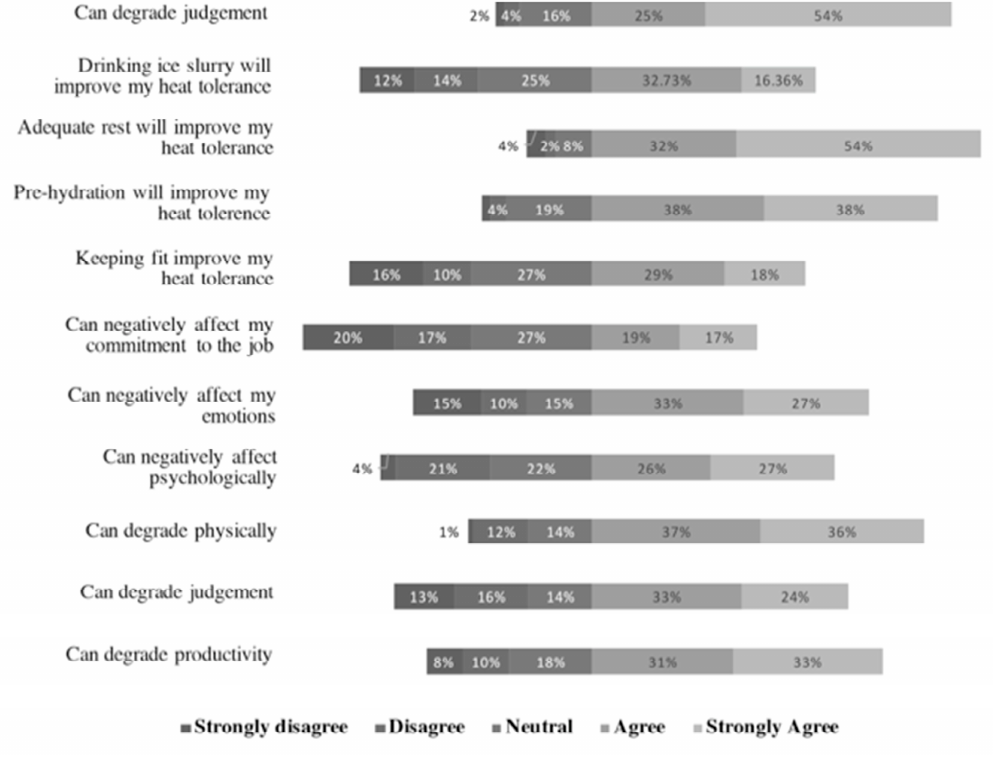
Figure 1. HCW respondents’ responses (total) to statements on knowledge on effects of heat stress on a 5-point Likert scale: (1) strongly disagree; (2) disagree; (3) neither agree nor disagree; (4) agree; (5) strongly agree.